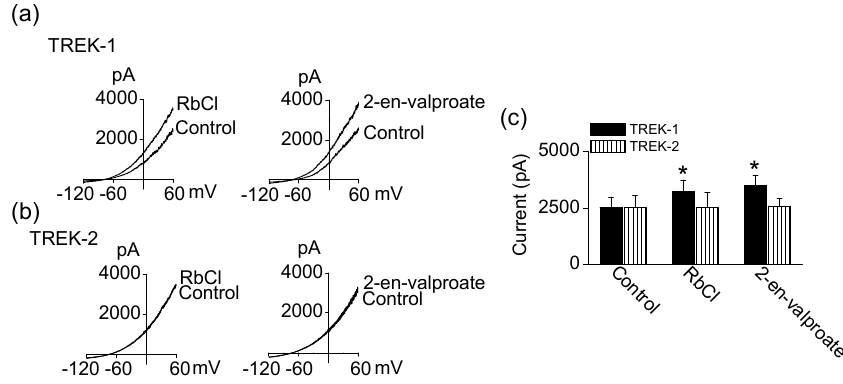
Figure 3. Effect of compounds structurally similar to LiCl and valproate on TREK-1 and TREK-2 current. ( a ) Effect of RbCl and 2-en-valproate on TREK-1; ( b ) No effect of RbCl and 2-en-valproate on TREK-2 activity; ( c ) Summary of effect of RbCl and 2-en-valproate on TREK currents. Each bar is the mean ± SD of five experiments. Asterisk (*) indicates a significant difference against the control without application of drugs ( p < 0.05).